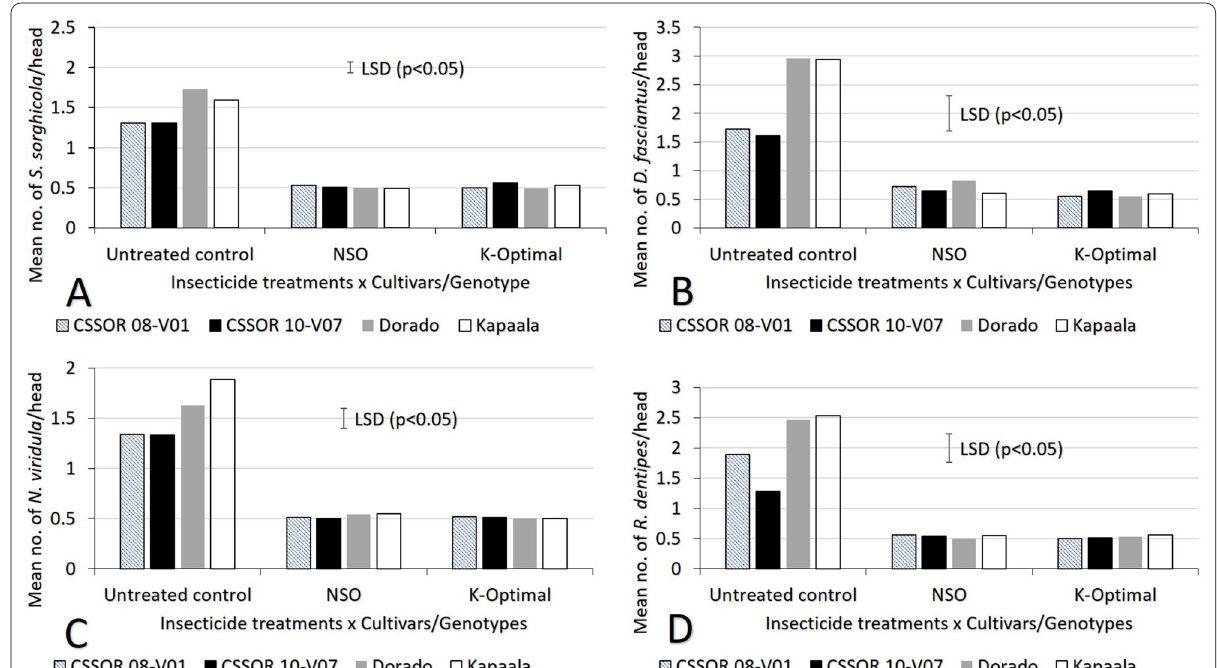
Fig. 3 Insecticide treatments Cultivars/Genotypes interaction effect on the mean number of A Stenodiplosis sorghicola, B Dysdercus fasciantus, C × Nezara viridula and D Riptortus dentipes in the 2018 cropping season. Note NSO